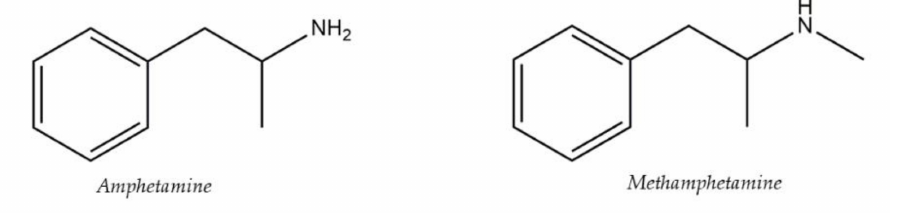
Figure 7. Chemical structures of amphetamine and